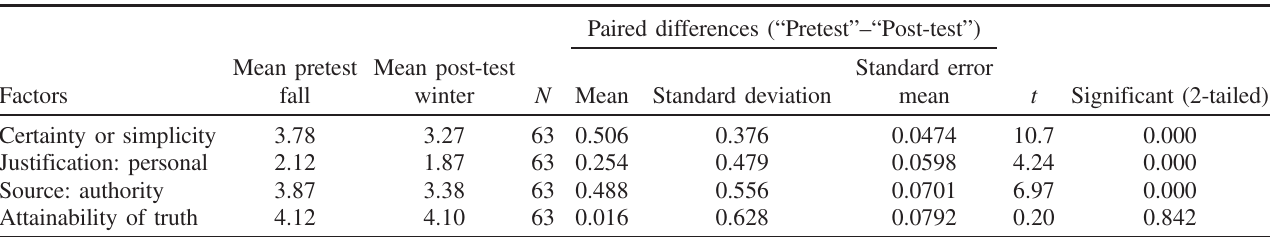
TABLE VIII. The results of paired t test for the experimental group at the end of the winter semester 2015 (post-test) compared to the beginning of the fall semester 2014